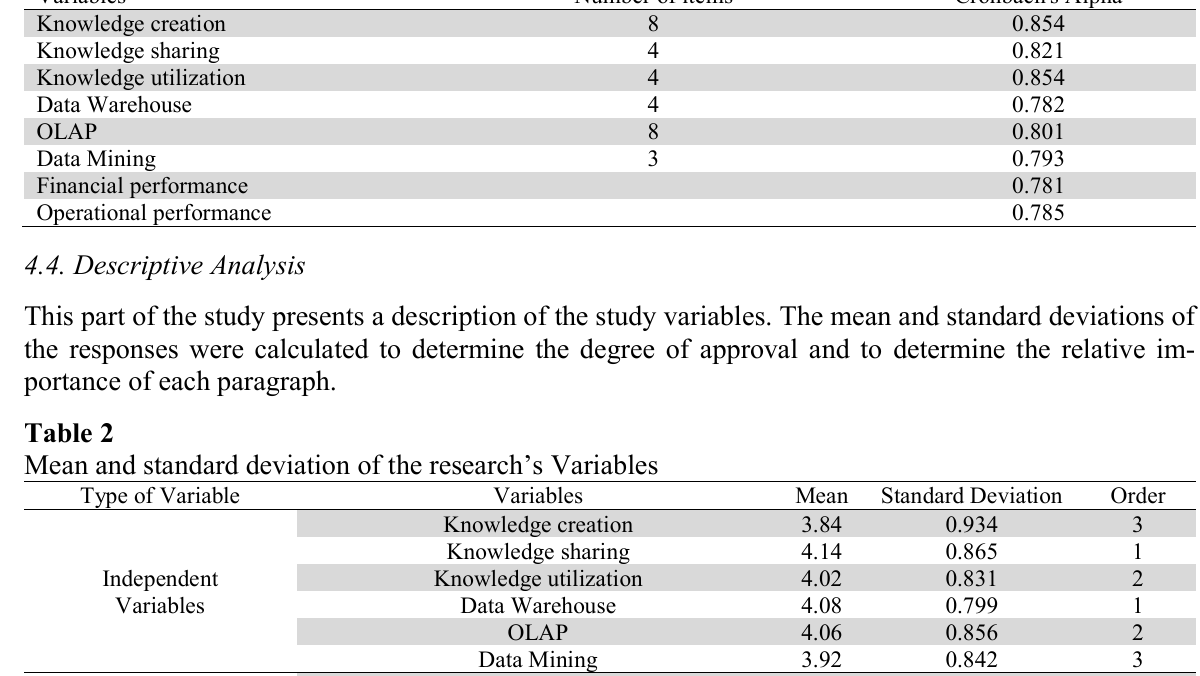
Cronbach's Alpha for all the variables Variables